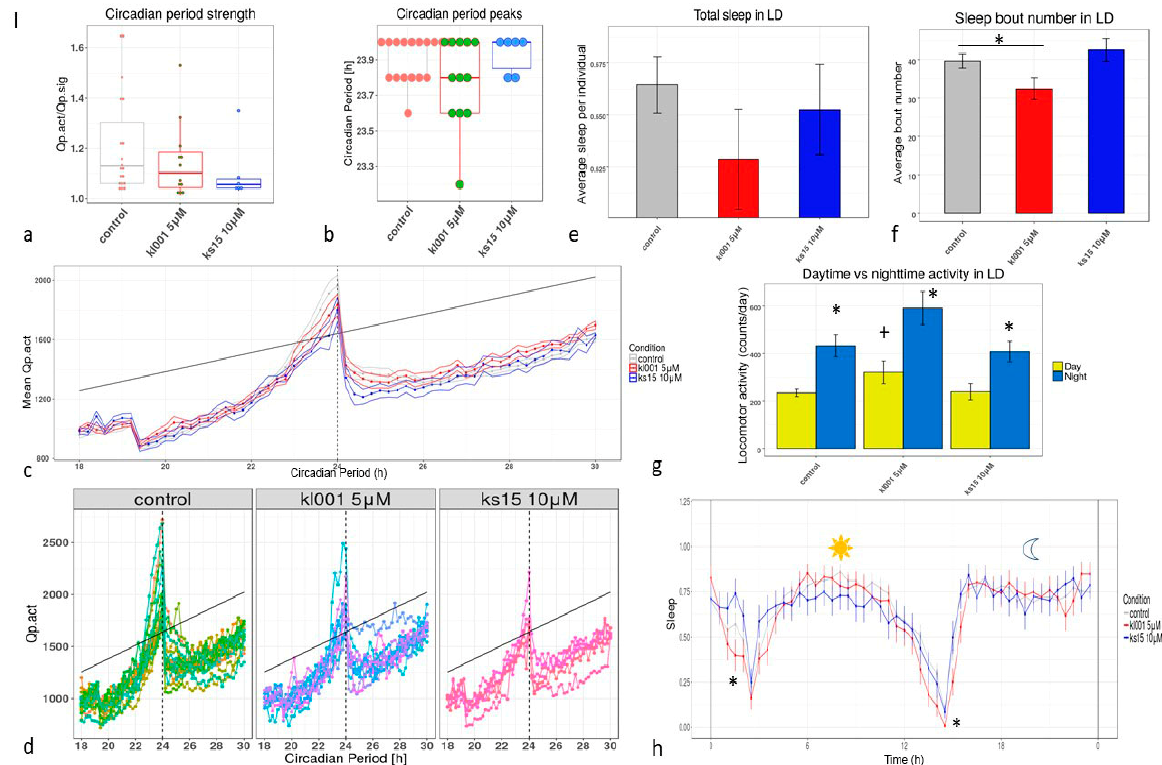
Figure 3. The parameters of male flies’ circadian rhythms, sleep/activity profile until the age of 5–12 days: ( a )—circadian period robustness; ( b )—circadian period peaks’ quantitative representation; ( c )—mean periodogram, ( d )—individual periodograms, ( e )—total sleep in LD, ( f )—sleep bout number in LD, *— p < 0.05, Mann-Whitney test; ( g )—comparative diagram daytime vs. night-time activity in LD, *—0.001 ANOVA with Tukey/Kramer procedure, also p < 0.01 with Scheffe’s procedure, for light and dark periods of the day, +— p < 0.001—for light and light in different cohorts by treatment, ( h )—sleep profile the differences in local distributions were measured with ANOVA for the control and KL001 groups. The chronobiotics did not significantly alter the period of the circadian rhythms in male flies of young age, but seriously affected the sleep profile in KL001-treated cohort; the sleep bout number decreased by 20% ( p < 0.05). The total activity was higher in daytime in the KL001 cohort as well as in night-time. Night-time activity was higher in all cohorts relative to daytime but not in the control group.